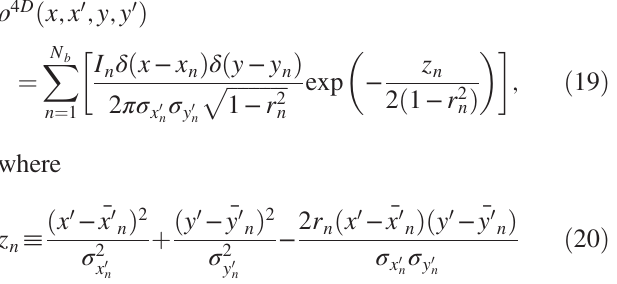
FIG. 4. Reconstruction of the 4D trace space density of the beam simulation in Fig. 1, shown as 2D projections of